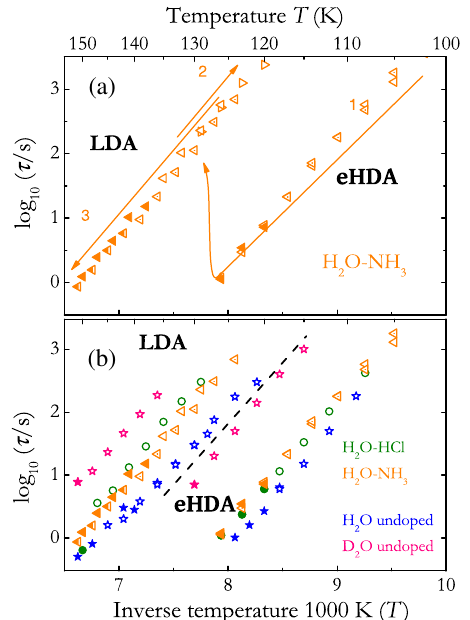
FIG. 6. (a) Dielectric relaxation times estimated for a NH 3 -doped eHDA sample. The numbered arrows indicate the applied temper- ature protocol. Triangles pointing to the left refer to data obtained during heating, those pointing to the right upon cooling. Filled and half-filled symbols refer to relaxation times assessed directly from the peak frequencies for two different samples; the open and dotted symbols are obtained by means of frequency-temperature super- position. (b) Compilation of relaxation times for various doped and undoped eHDA and LDA samples as obtained in heating runs. Relaxation times to the left of the dashed line refer to LDA, those to the right to eHDA. Data for undoped (hydrogenated as well as deuterated) samples are from previous work [14,46,47]. These latter data indicate that the dynamics in deuterated LDA (eHDA) is of the order of 20 (50) times slower as compared to that in hydrogenated LDA (eHDA).